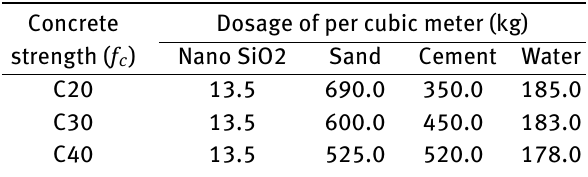
Figure 3: All composite columns before compression test Table 3: Mix proportion of nano-silica concrete Concrete